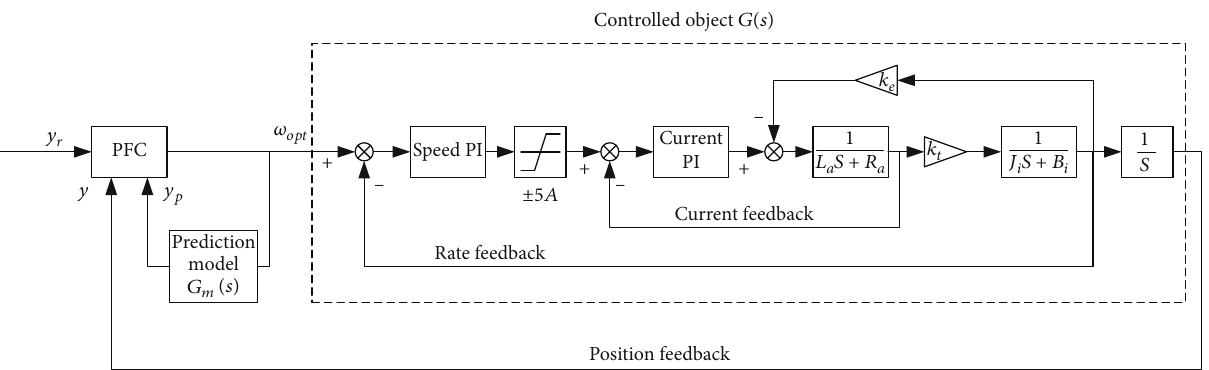
Figure 5: OG position controller block diagram. Table 2: Model parameters. Model